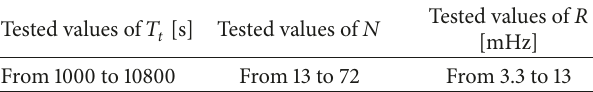
simulations. Tested values of